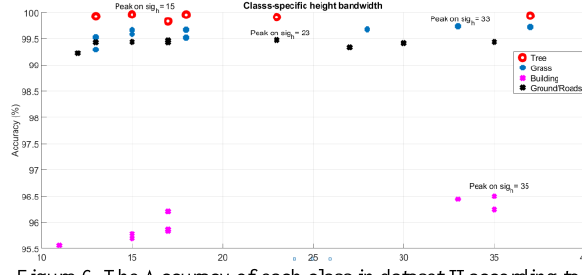
Figure 6. The Accuracy of each class in dataset II according to the height bandwidth.